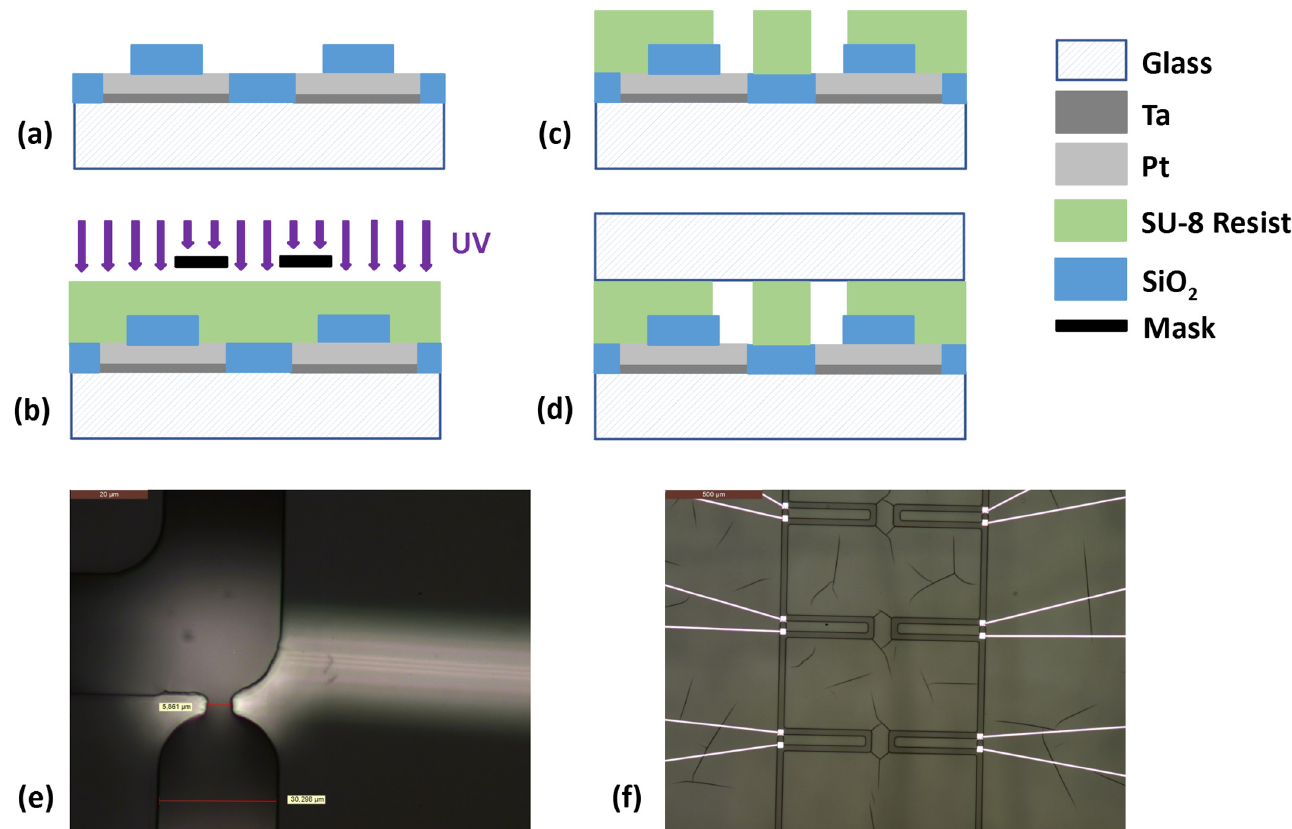
Figure 11. The main microfluidic structure fabrication steps. ( a ) The previously fabricated microelectrodes. ( b ) SU-8 deposition and insolation. ( c ) SU-8 development. ( d ) The bonding of a piece of glass to the SU-8 to close the channels. ( e ) An image of the narrow channel of a microfluidic trap. ( f ) A view of the microfluidic channel over the microelectrodes.